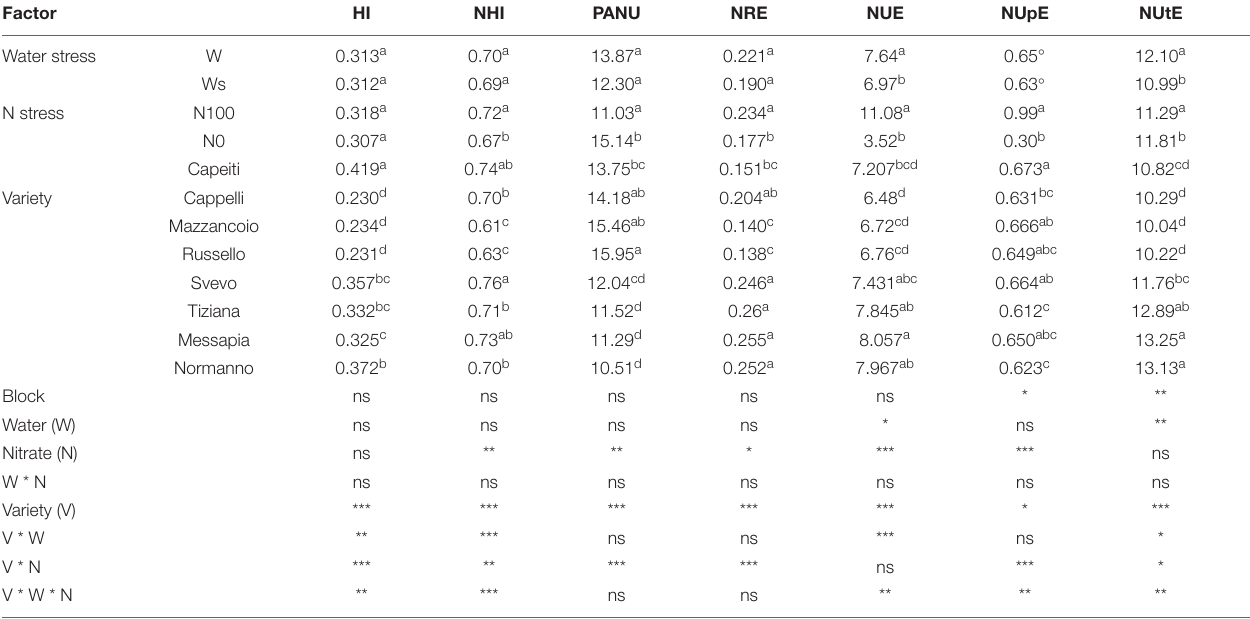
TABLE 2 | Physiologic traits of wheat varieties under two N (0 and 100) and water (20 and 40) regimes in field condition. Factor HI NHI PANU NRE NUE NUpE NUtE Water stress